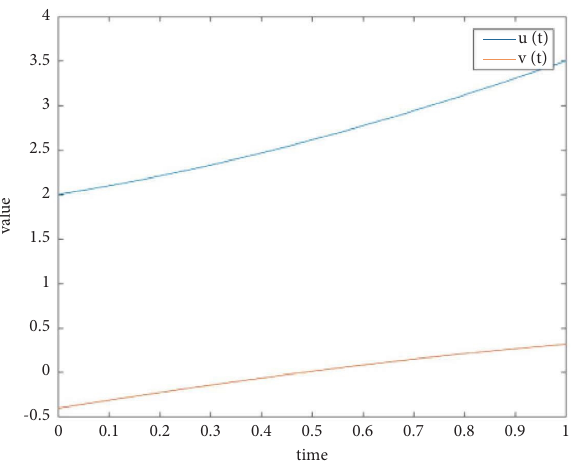
Figure 2: Te solution of Example 2.